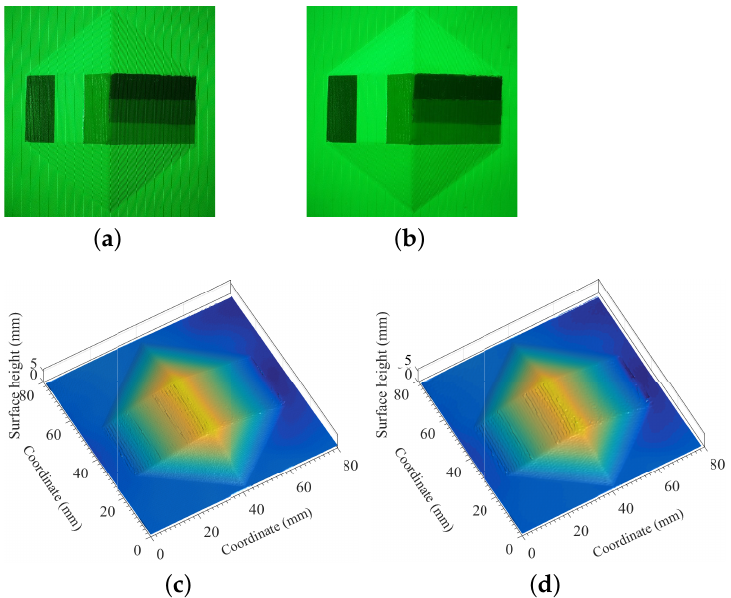
Figure 14. Reconstruction of 3D-printed color object with optical filtering. ( a ) background illuminance E = 505 Lux ; ( b ) background illuminance E = 3050 Lux ; ( c ) retrieval using the image of ( a ); ( d ) retrieval using the image of ( b ).